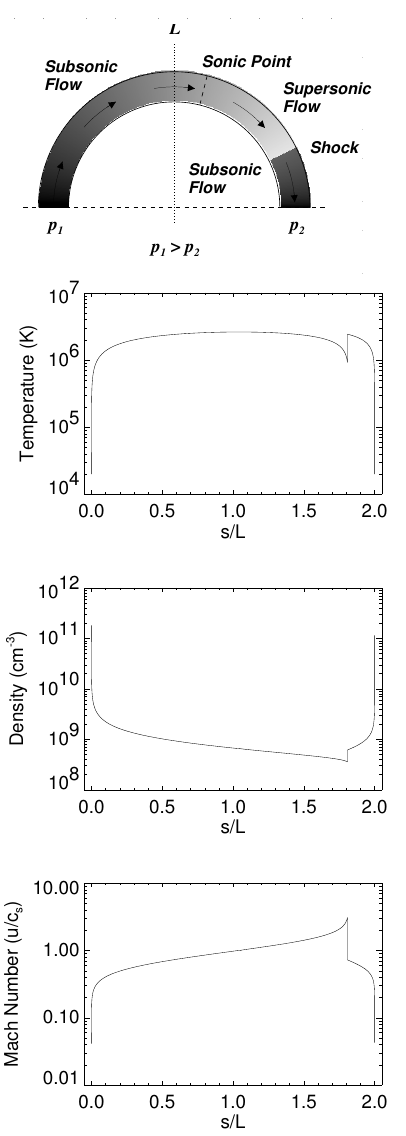
Figure 18: Example of solutions of a siphon flow loop model including a shock. Image reproduced with permission from Orlando and Peres (1999), copyright by